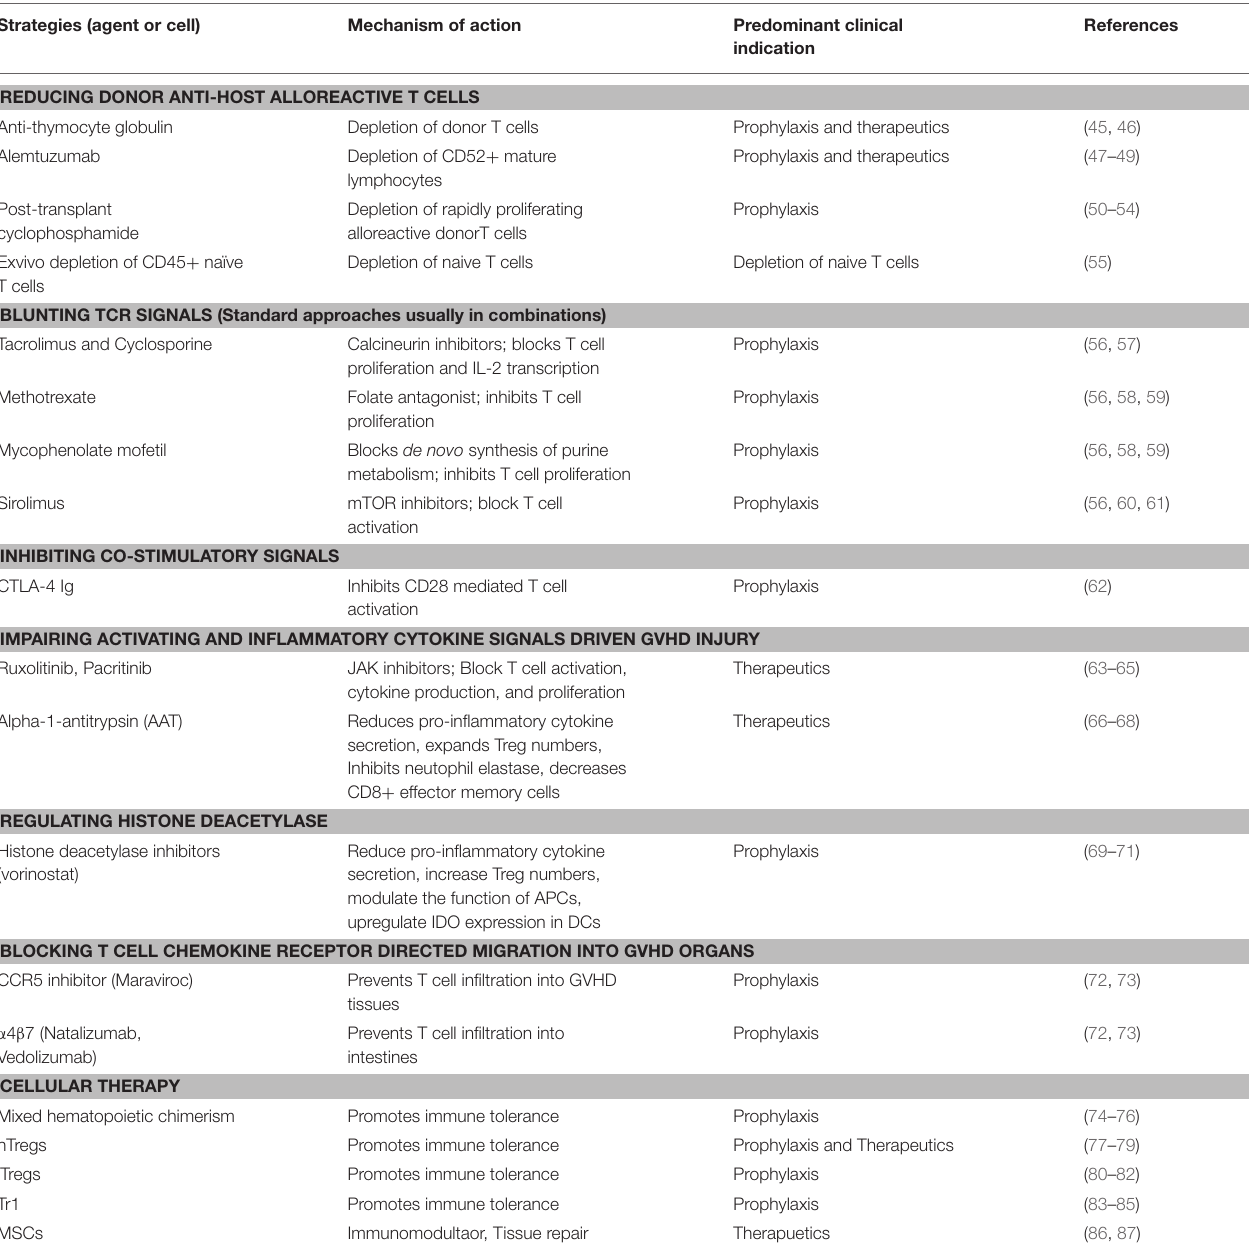
TABLE 1 | Approaches to blunt the distinct stages of GVHD